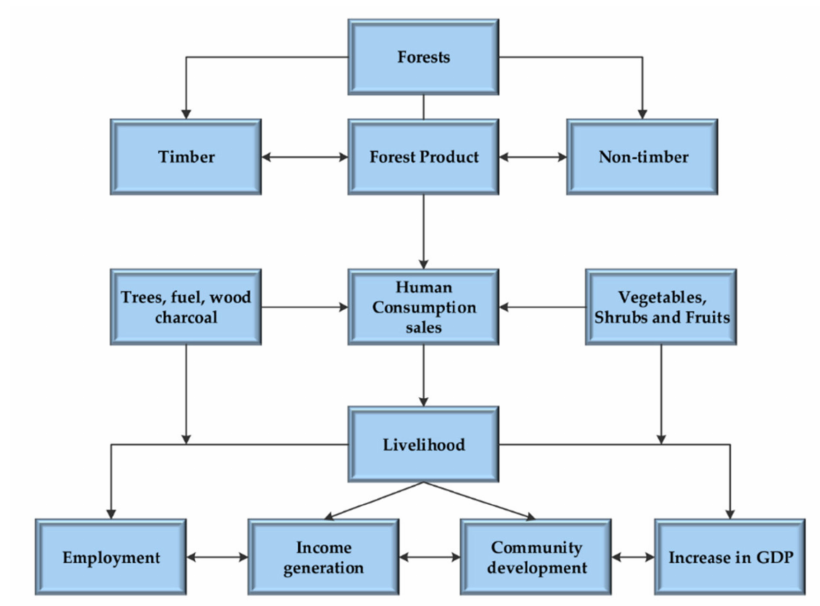
Figure 1. Version of livelihood system